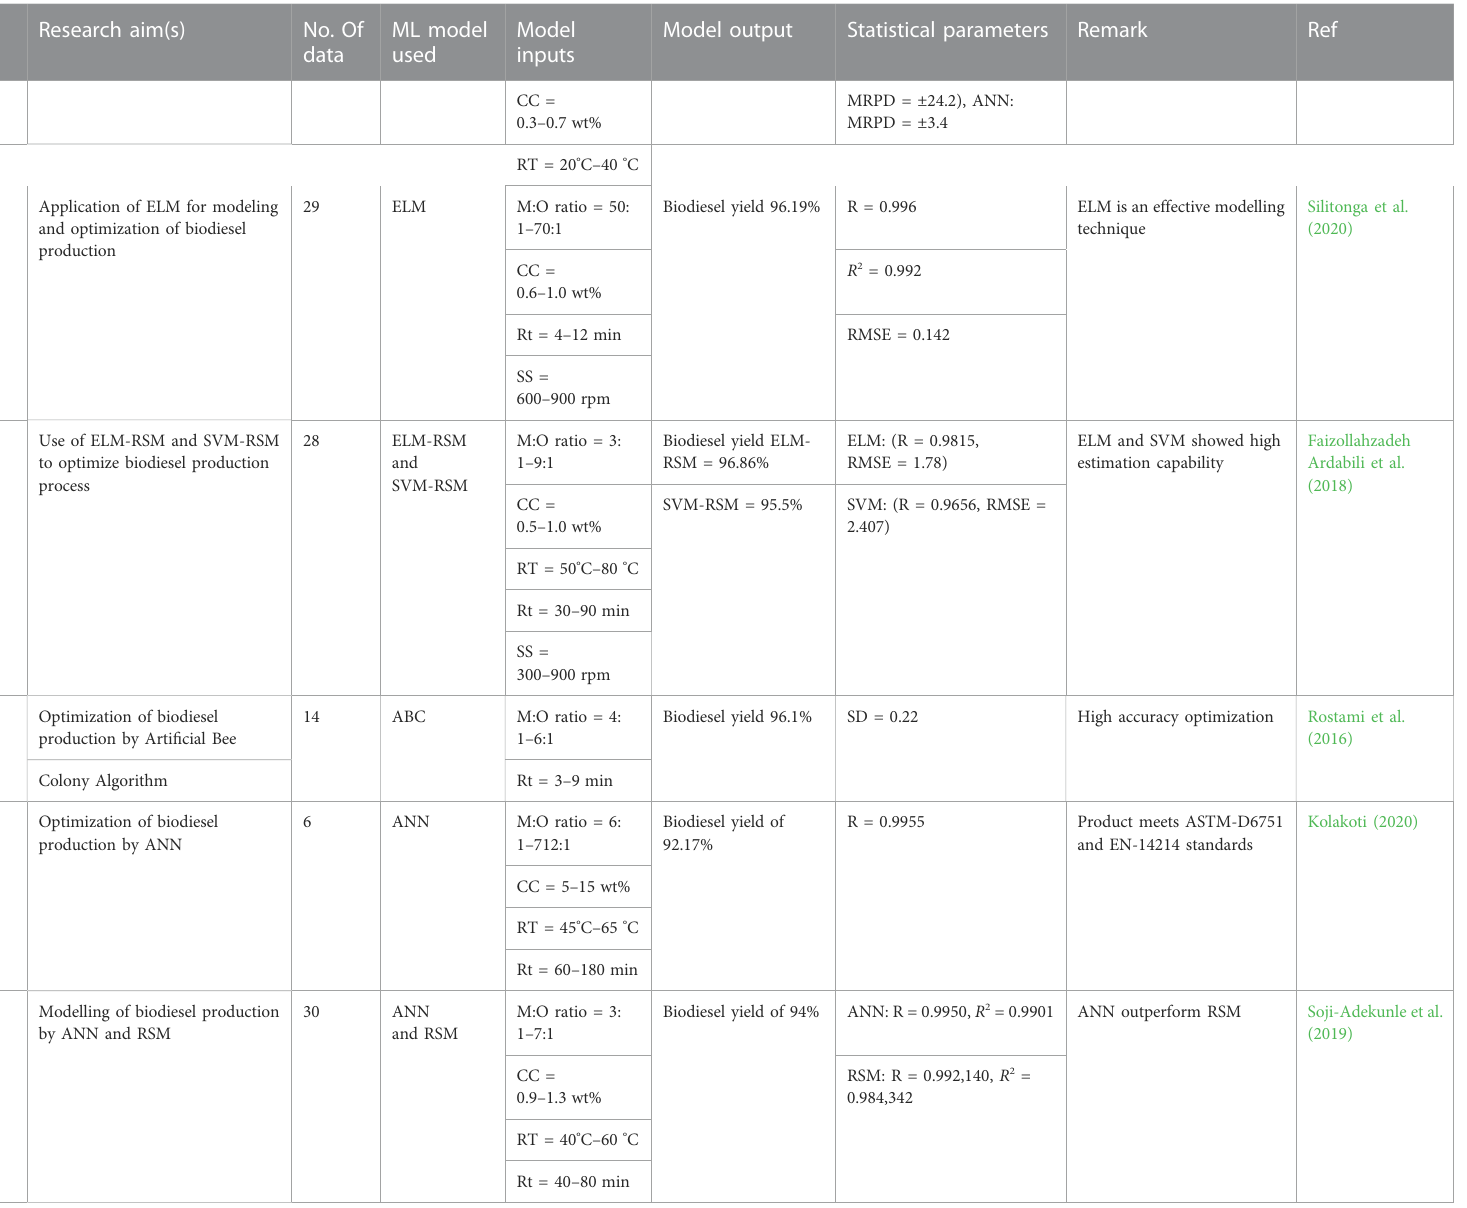
TABLE 6 ( Continued ) Application of ML models for modelling, predicting, and optimizing biodiesel process